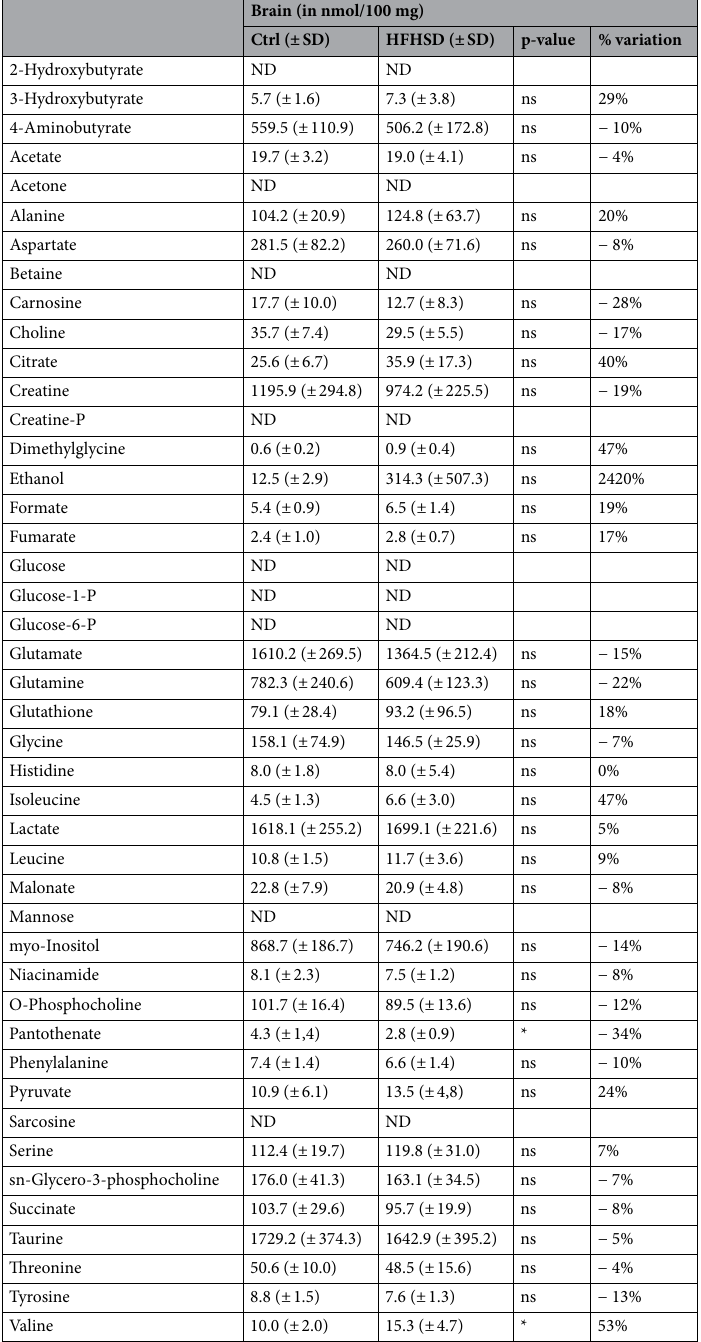
Table 8. Metabolite concentrations measured by NMR in the brain of SD and HFHSD mice. Results are expressed as mean ± standard deviation (SD) and are in nmol/100 mg of brain. Data are mean of n = 8 mice per group; Results of unpaired two-tailed t-test are indicated as non-determined (ND), non-significant (NS), p < 0.05 (*), p < 0.01 (**), p < 0.001 (***) and p < 0.0001 (****). Percentages of variation between HFHSD and control fed mice are